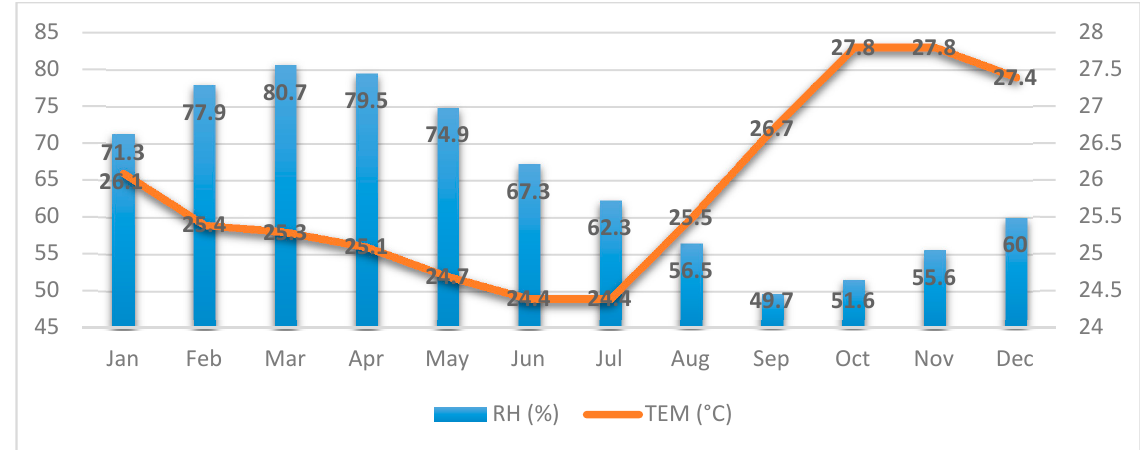
Figure 6. Average compensated temperature and relative air humidity in Cariri Cearense—averages from 1981 to 2010. Data Source: National Institute of Meteorology, Brazil (INMET) [86], adapted for the study.